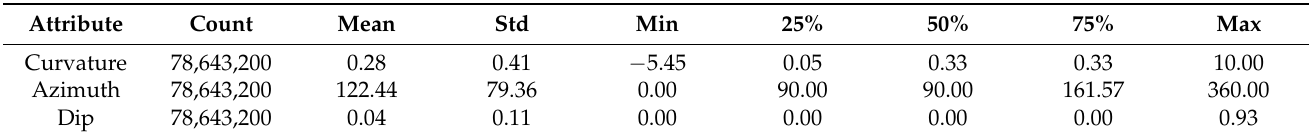
Table 3. The basic statistic of salt delineation seismic